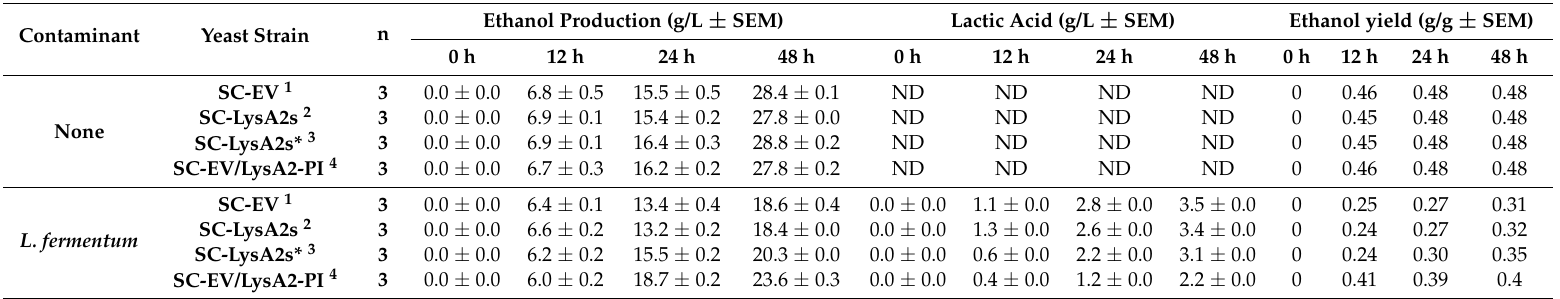
Table 4. Fermentation profile of SC-EV 1 , SC-LysA2s 2 , SC-LysA2s* 3 and purified LysA2 4 with L. fermentum in